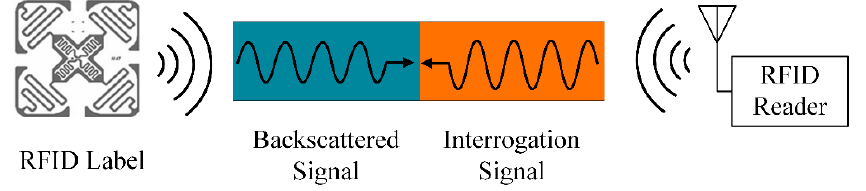
Figure 5. The sensing principle of UHF RFID: the information exchange between the tag and the reader is achieved through the interrogation signal and the backscattered signal.